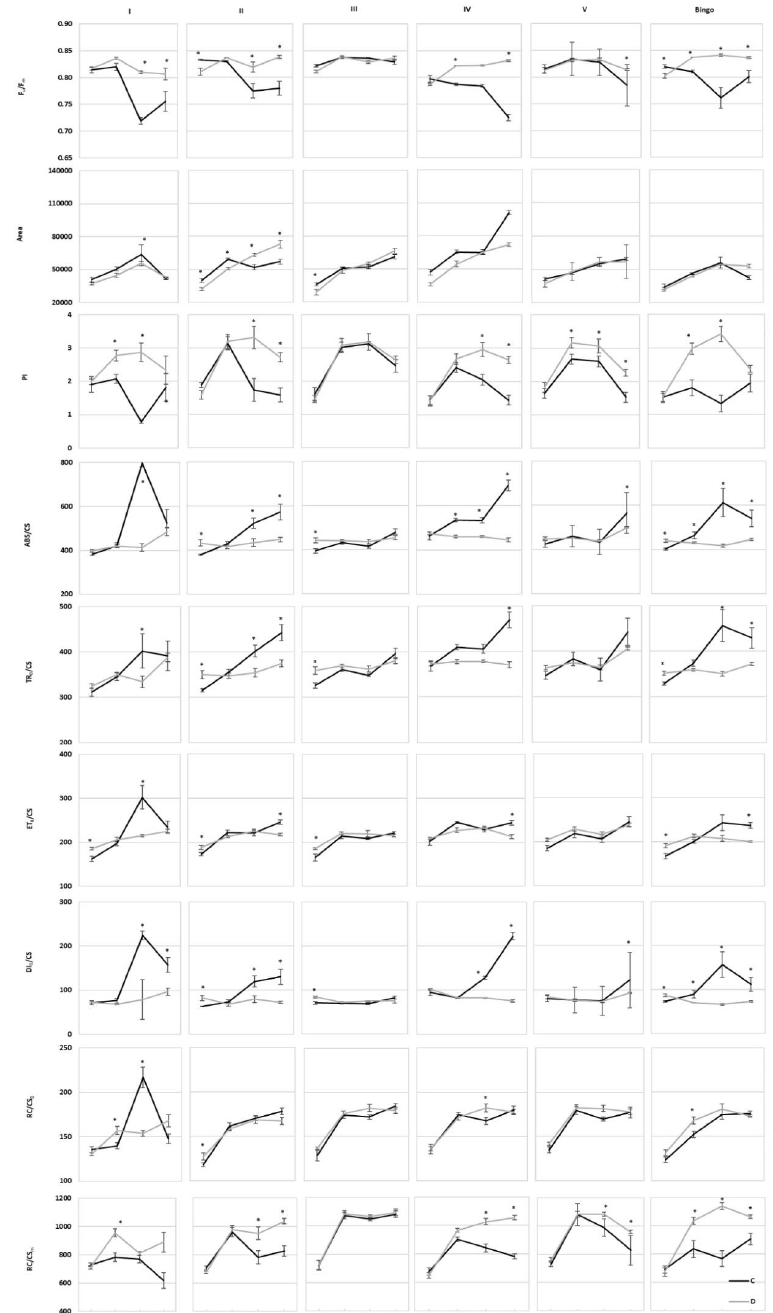
Figure 8. Chlorophyll a fluorescence parameters in oat leaves on 1st (1stD) and 14th (14thD) day of drought, panicle ejection (PE) and milk maturity (MM) phase. F v / F m —maximum photochemical e ffi ciency of PSII; Area—area over the chlorophyll a fluorescence induction curve; PI—overall performance index of PSII photochemistry; ABS / CS—light energy absorption; TR 0 / CS—excitation energy trapped in PSII reaction centers; ET 0 / CS—energy used for electron transport; DI 0 / CS—energy dissipated from PSII; RC / CS 0 —number of active reaction centers in the excited leaf fragment; RC / CS m —number of active reaction centers in the relaxation state of leaf fragment; C—control, 70% FWC, black line; D—drought, 25% FWC, grey line. The mean values (n = 5) ± SE marked with an asterisk (*) are significantly di ff erent at p ≤ 0.05 according to the Student’s t